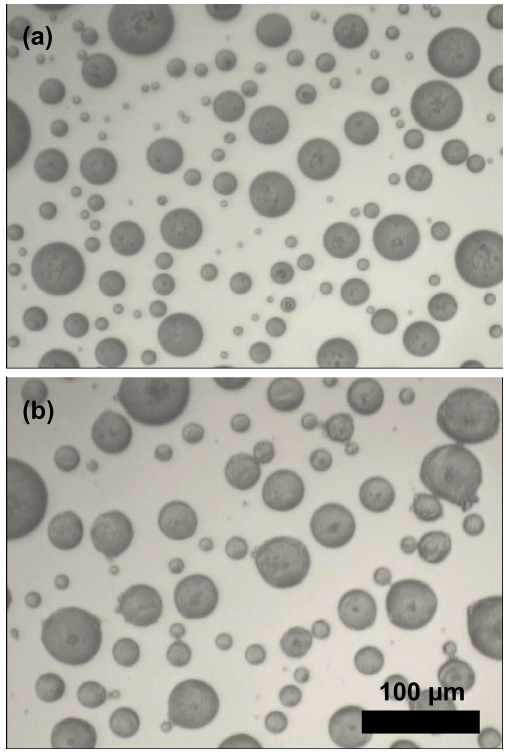
Figure 3. 20x images of unfrozen droplets containing 1% KGa-1b (a) , and the same drops after an immersion freezing experiment (b)